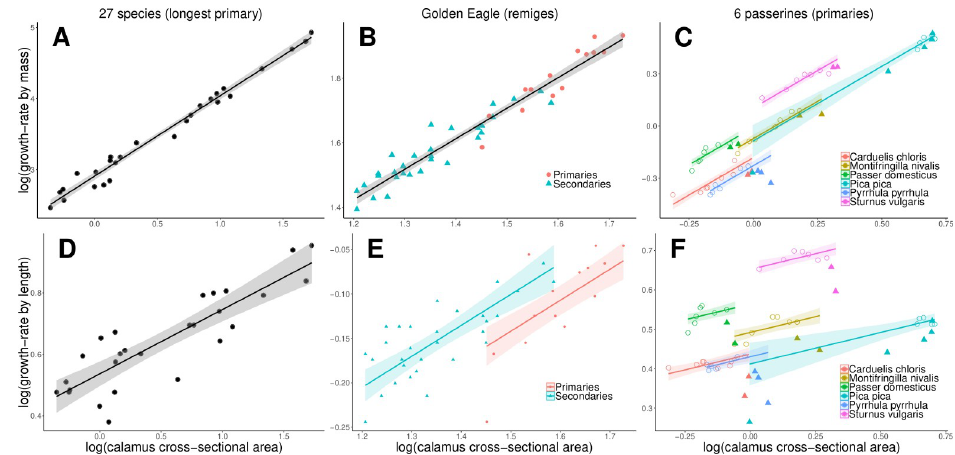
Fig 2. Feather growth-rate and cross-sectional area of the calamus. Relationships between feather growth-rates by mass (A—C), or alternatively feather growth-rate by length (D—F), and the cross-sectional area of the calamus for three datasets: A and D: longest primary of 27 species, B and E: remiges of Golden Eagle (dots = primaries, triangles = secondaries), C and F: primaries of 6 passerine species (colours; filled triangles = ‘wing-tip primaries’, open circles = ‘proximal primaries‘). The lines indicate the regressions according to the analyses (see Table 1 and S2 Table, S4 Table and S6 Table): A, B, D: for the entire dataset; E: with a different intercept for primaries and secondaries; C and F: for the ‘proximal primaries’ only with a different intercept according to